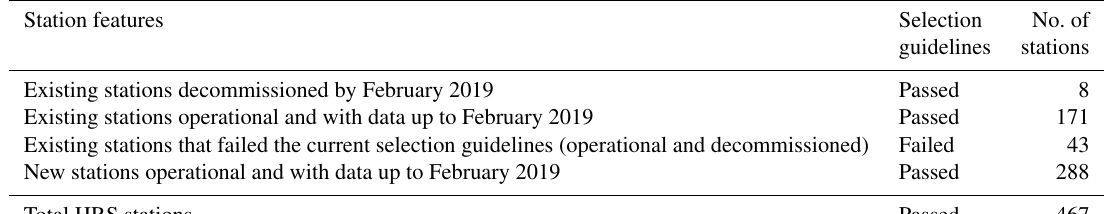
Table 1. Total number of stations.